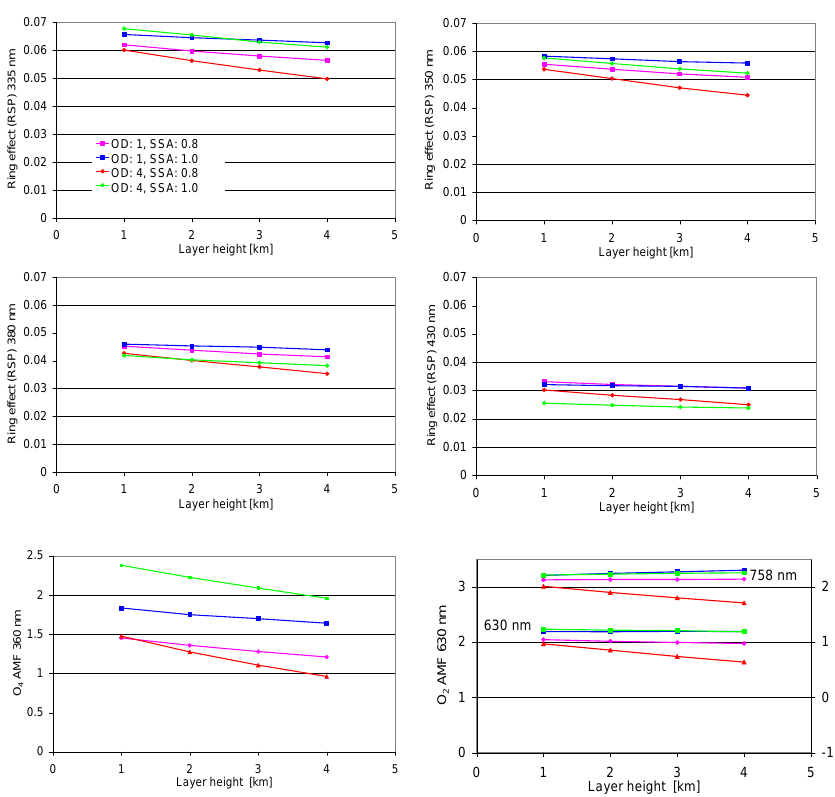
Fig. 13 Dependence of the Ring effect and the O 2 and O 4 absorptions on the aerosol layer height (the x-axis indicates the upper boundary of the aerosol layer; the lower boundary is the surface). The calculations are performed for SZA of 30° and a viewing angle of -90° (nadir). The aerosol asymmetry parameter was assumed to be 0.68. For 758 nm the surface albedo was set to 20%, for 630 nm to 10%, and for all other wavelengths to 5%.